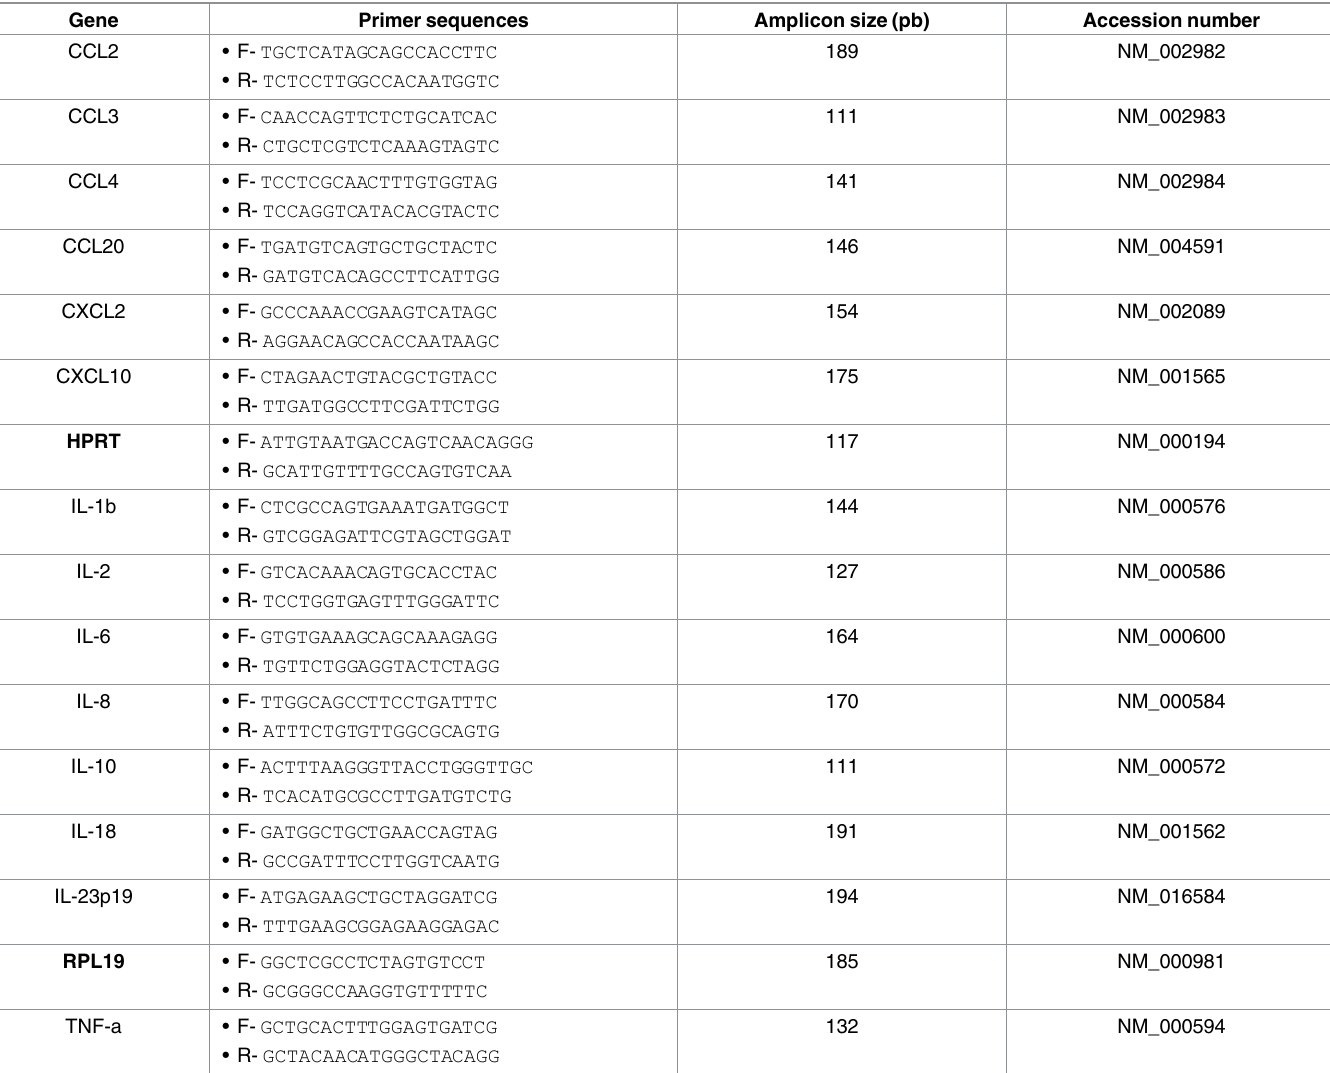
Table 1. Human gene RT-qPCR primers